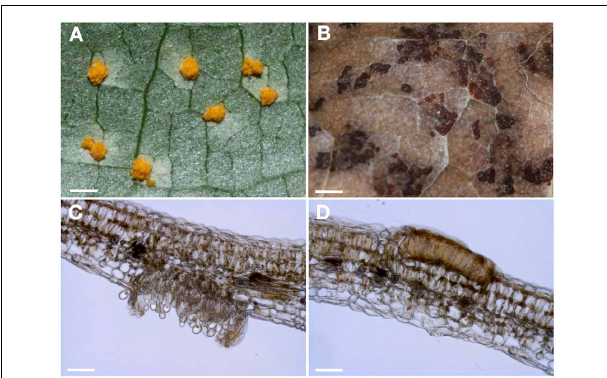
FIGURE 1 | M. larici-populina uredinia and telia on poplar leaves. (A) Macroscopic picture of uredinia formed 7 days post inoculation by the virulent M. larici-populina 98AG31 strain on the abaxial surface of leaves of the “Beaupré” poplar cultivar. (B) Macroscopic picture of telia observed early in autumn on the adaxial surface of senescent “Beaupré” leaves naturally infected by M. larici-populina . Scale bar = 1mm. (C) Transversal section of a “Beaupré” leaf infected by the virulent M. larici-populina 98AG31 strain showing a mature uredinium releasing urediniospores on the abaxial surface. (D) Transversal section of a “Beaupré” leaf naturally infected by M. larici-populina showing a mature telia on the adaxial surface into which teliospores are tightly encapsulated. Scale bar = 50 μ m.